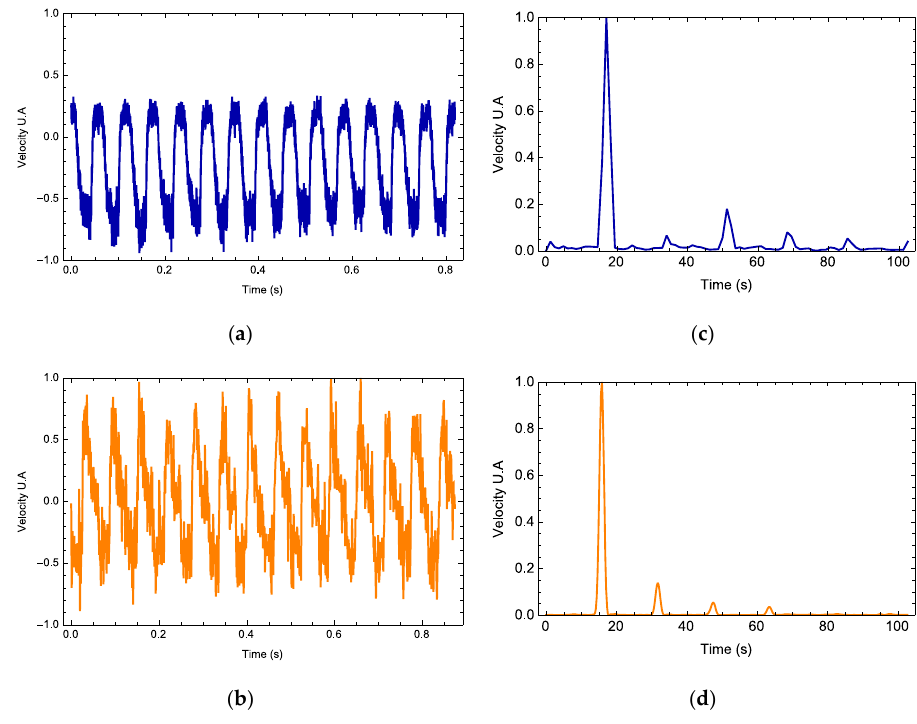
Figure 6. Photodyne movement velocity ( a , b ) and Fourier spectrum (c , d ). Comparison of the theoretical (orange) and experimental results (blue). Rectangle signal, input frequency of 15 Hz. Calculated value of h = 33.2 and n ligth = 0.5.